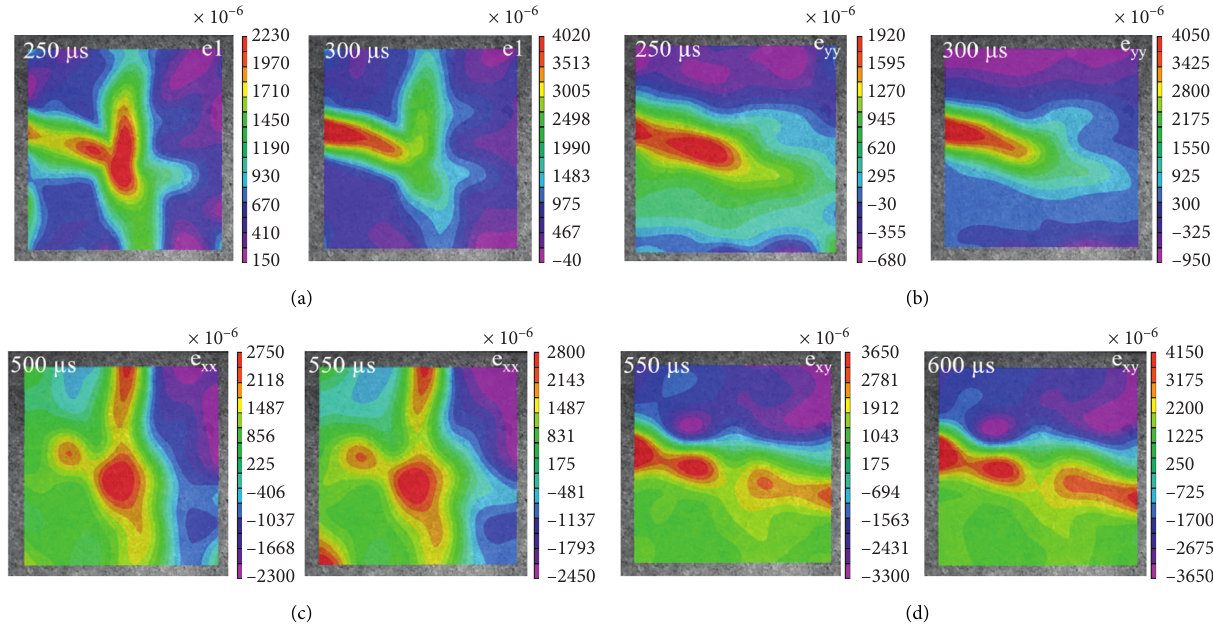
Figure 7: Full-field strain characterizations of crack initiation for test 1: (a) e 1; (b) e